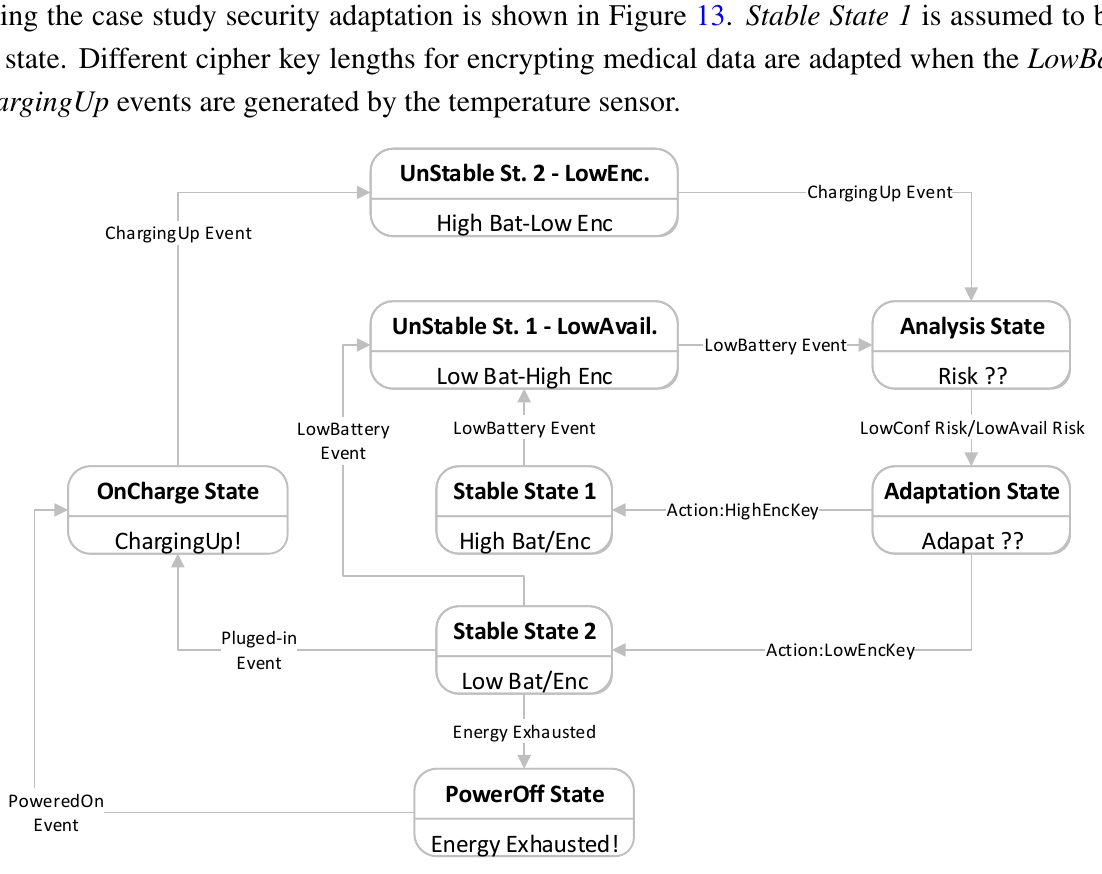
Figure 13. Adapting security to low availability/confidentiality